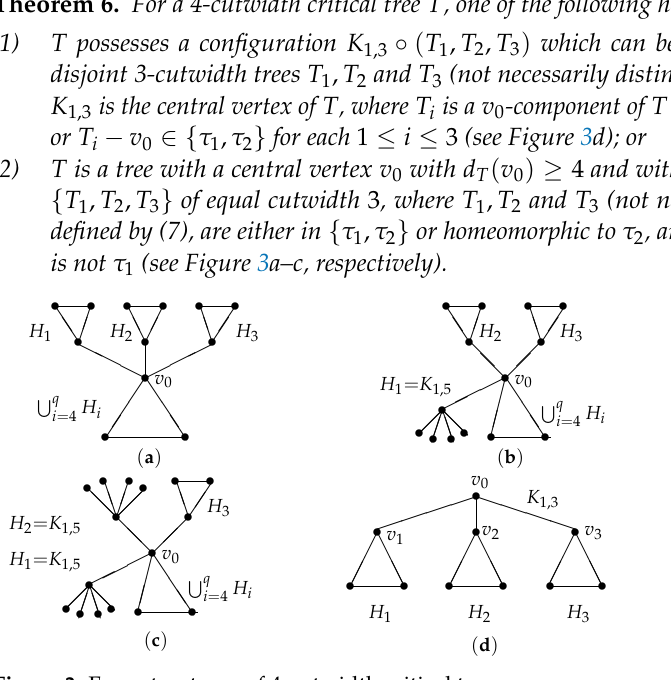
Figure 3. Four structures of 4-cutwidth critical